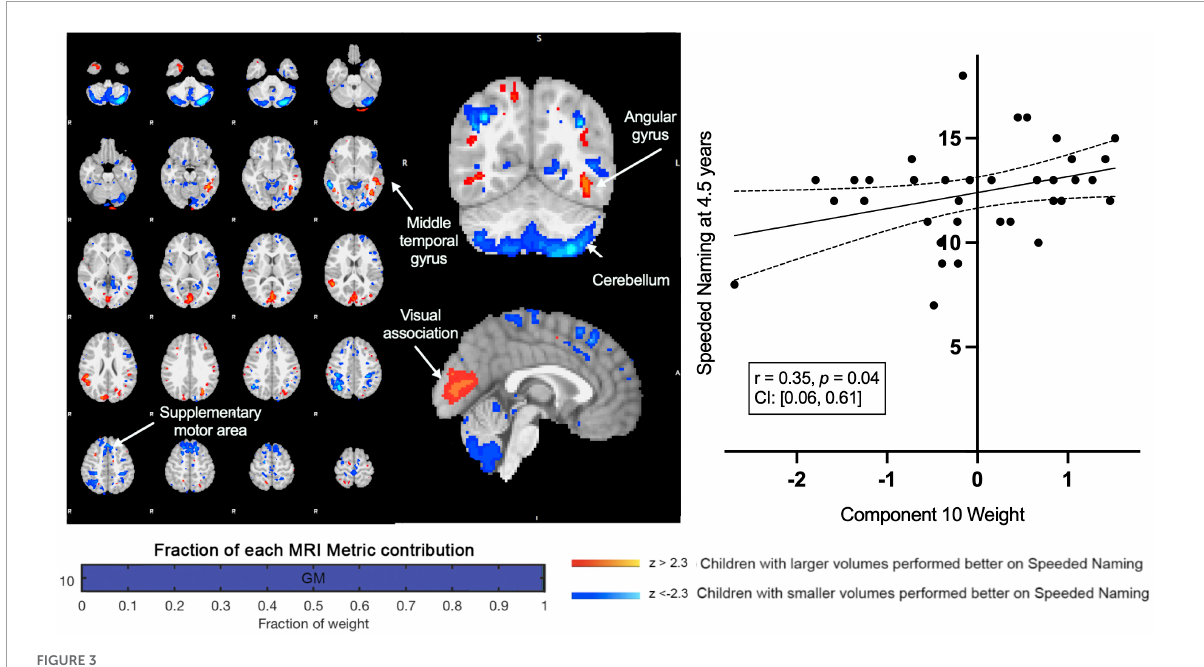
FIGURE3 Component 10 was dominated by gray matter contributions. This component was positively correlated with Speeded Naming performance at 4.5 years. For regions in red (positive clusters), children with larger volumes performed better on Speeded Naming, and for regions in blue (negative clusters), children with smaller volumes performed better on Speeded